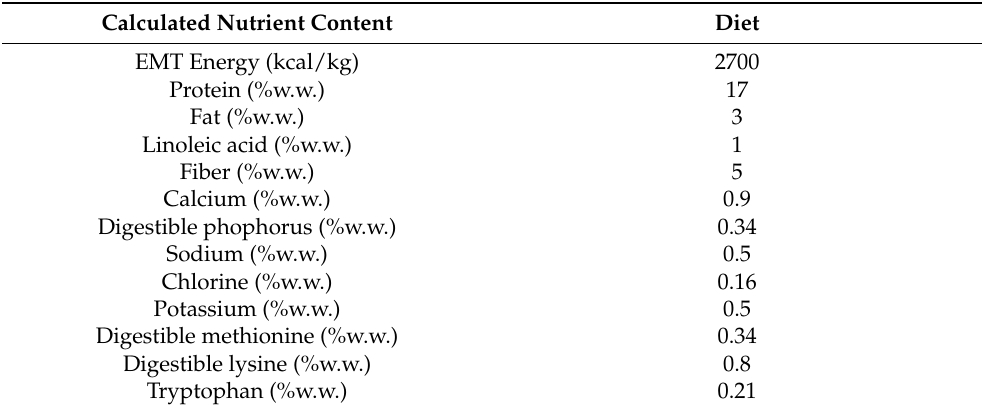
Table 4. Calculated nutrient composition of the